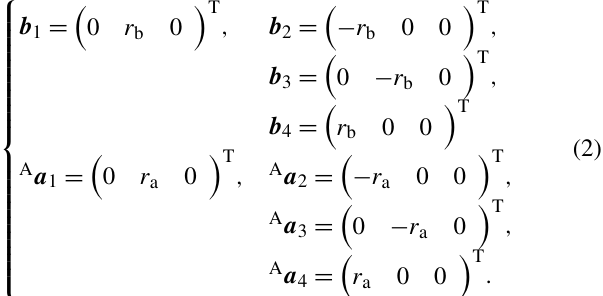
Figure 2. Structure diagram of a parallel mechanism.